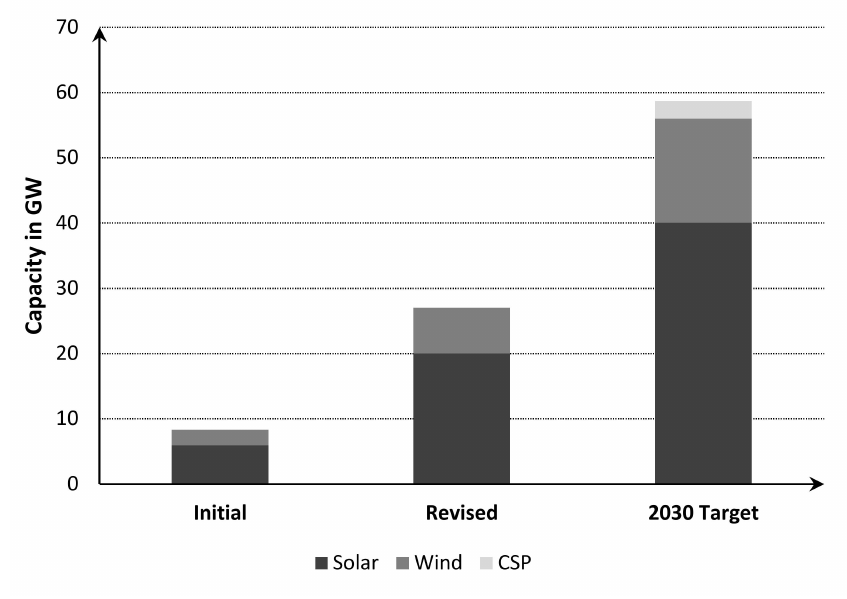
Figure 1. The vision of renewable energy in KSA for 2030.